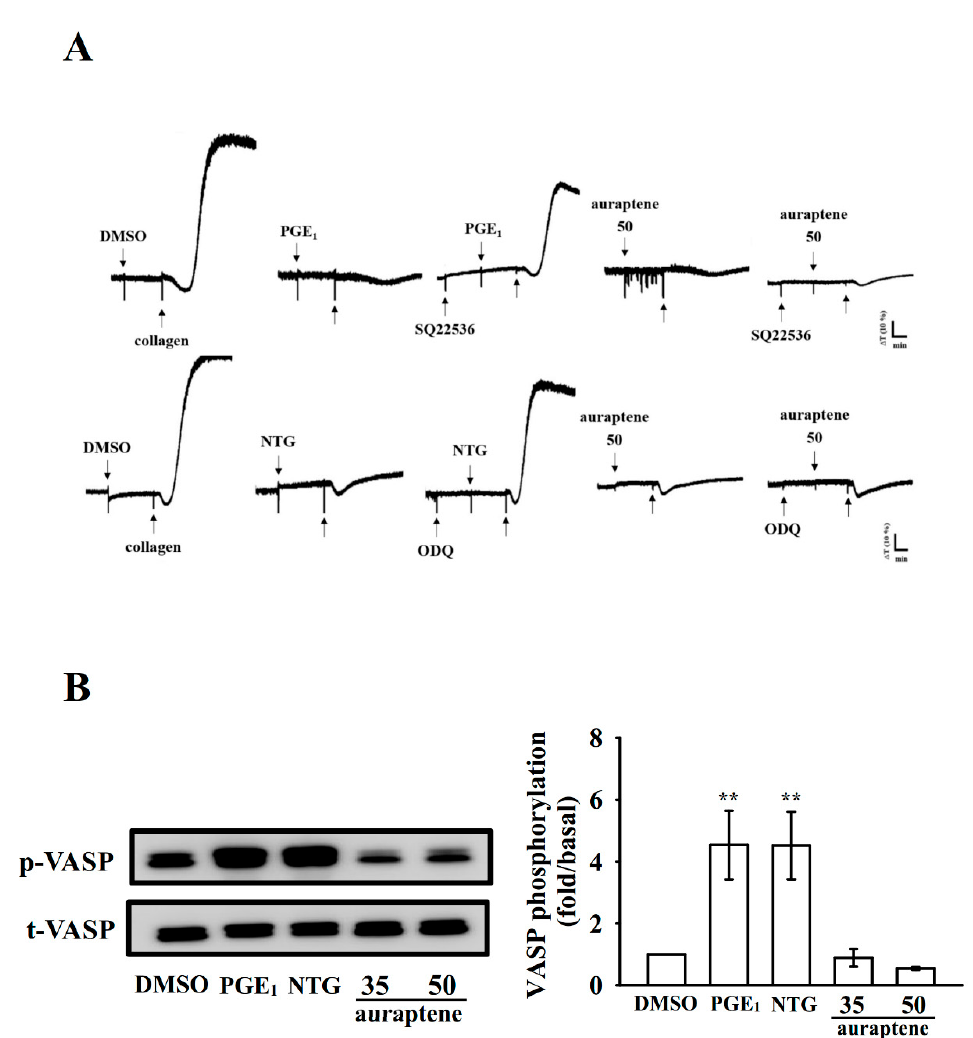
Figure 6. Effectiveness of auraptene in cyclic nucleotides and vasodilator-stimulated phosphoprotein (VASP) phosphorylation as well as acute pulmonary thrombosis. Washed platelets were preincubated with ( A ) prostaglandin E 1 (PGE 1 ; 10 µ M), nitroglycerin (NTG; 10 µ M), or auraptene (50 µ M) in the presence of SQ22536 (100 µ M) or ODQ (10 µ M) 3 min before the addition of collagen (1 µ g / mL) to activate platelet aggregation. ( B ) Washed platelets were preincubated with 0.1% DMSO, PGE 1 (1 µ M), NTG (10 µ M), and auraptene (35 and 50 µ M) for immunoblotting the Vasodilator-stimulated phosphoprotein (VASP) phosphorylation. Profiles in (A) are representative of four independent experiments. Data in ( B ) are presented as mean ± SEM ( n = 4). ** p < 0.01, compared with the 0.1% DMSO-treated